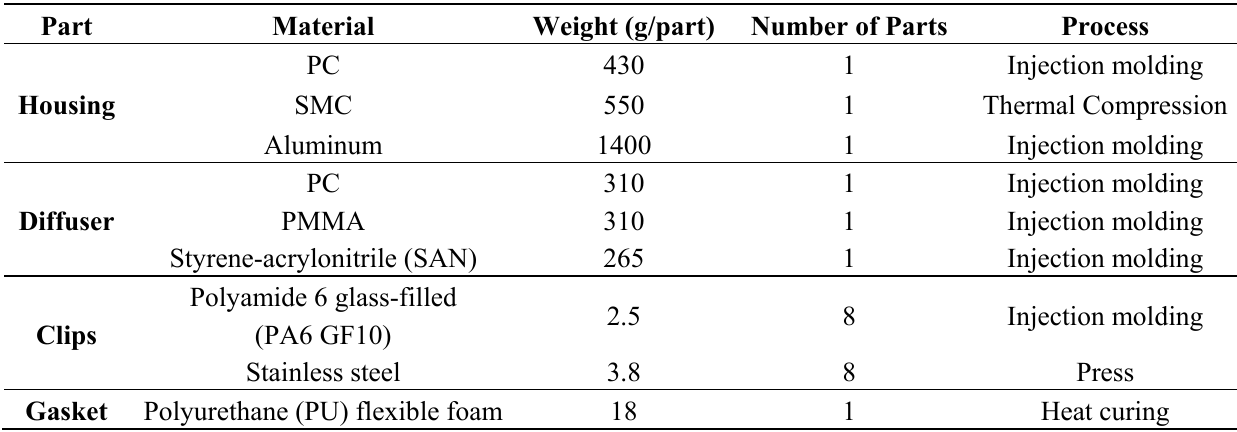
Table 1. Alternative part materials. PC, polycarbonate; SMC, sheet molding